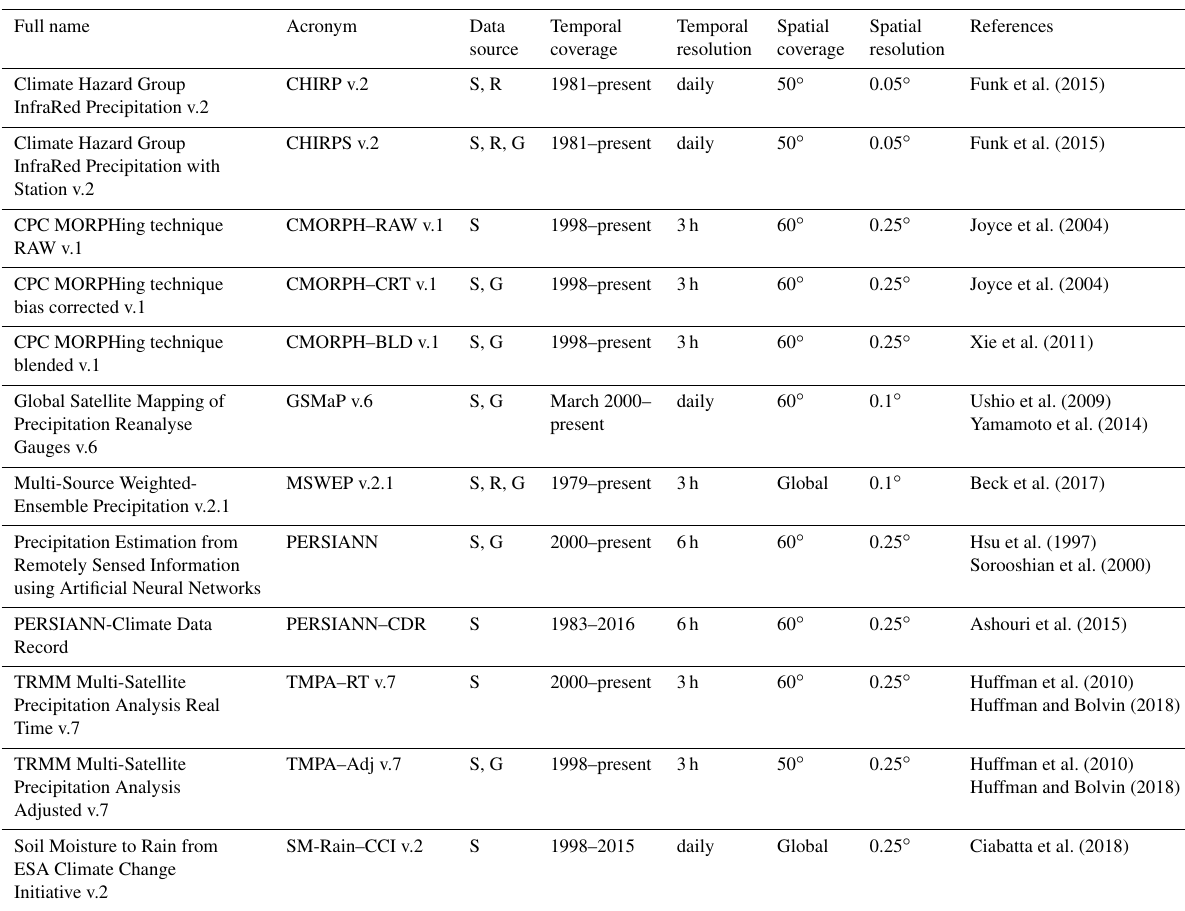
Table 1. Main characteristics and references of the 12 SPPs considered. In the data source column, S stands for satellite, R for reanalysis, and G for gauge information.